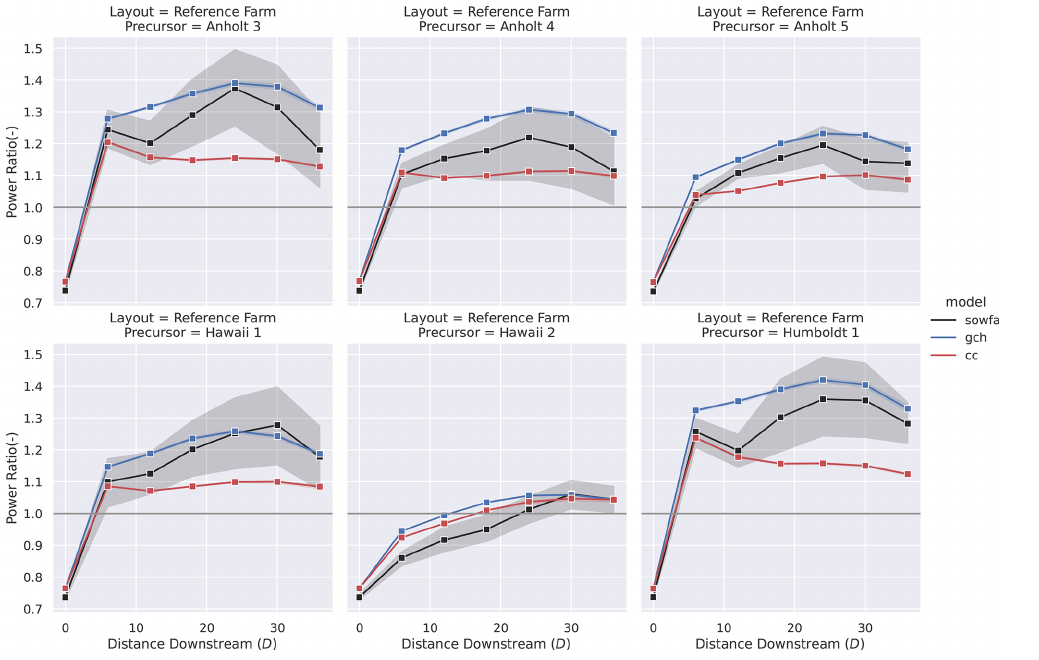
Figure 7. Comparing the ratio of the average power produced per wind turbine row (average indicated by the point, shading indicating confidence interval) for the Reference Farm type across precursors when applying a pattern of decreasing yaw angles per row starting at 30 ◦ and going to 0 ◦ by increments of 5 ◦